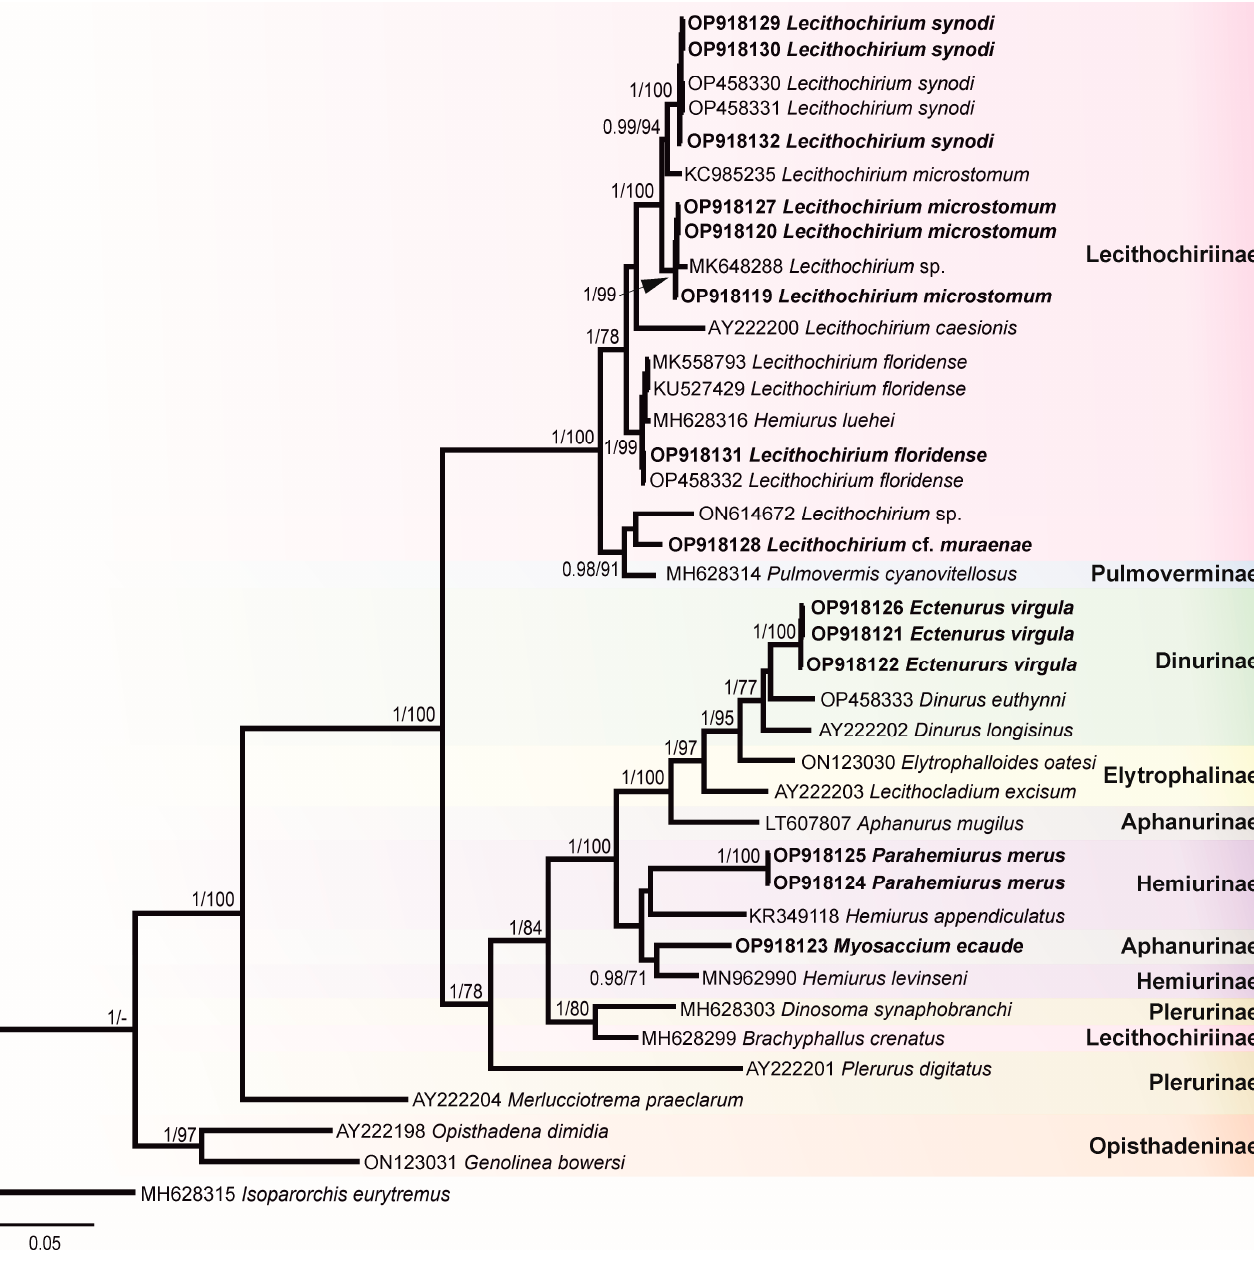
Figure 4. Phylogenetic tree resulted from Bayesian inference (BI) analysis of the 28S rDNA sequences datasets of the Hemiuridae with nodal support values shown at the node as BI/ML (maximum likelihood). Support values <0.90 (BI) and 70 (ML) are not shown. Sequences generated in the present study are highlighted in